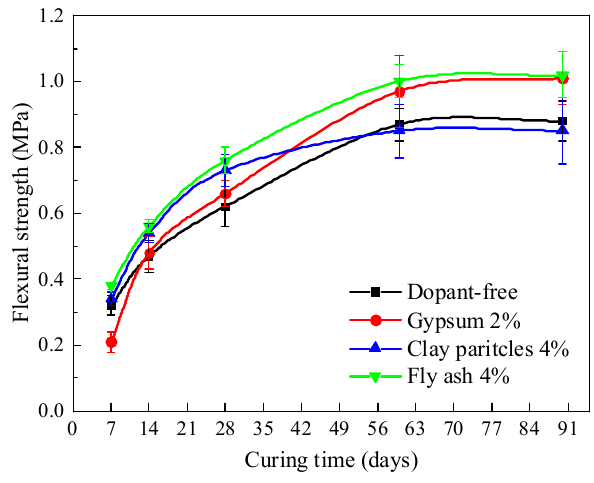
Figure 8. Flexural strength with different replacement ratios of the additives. Table 6. Test results for flexural strength (MPa).